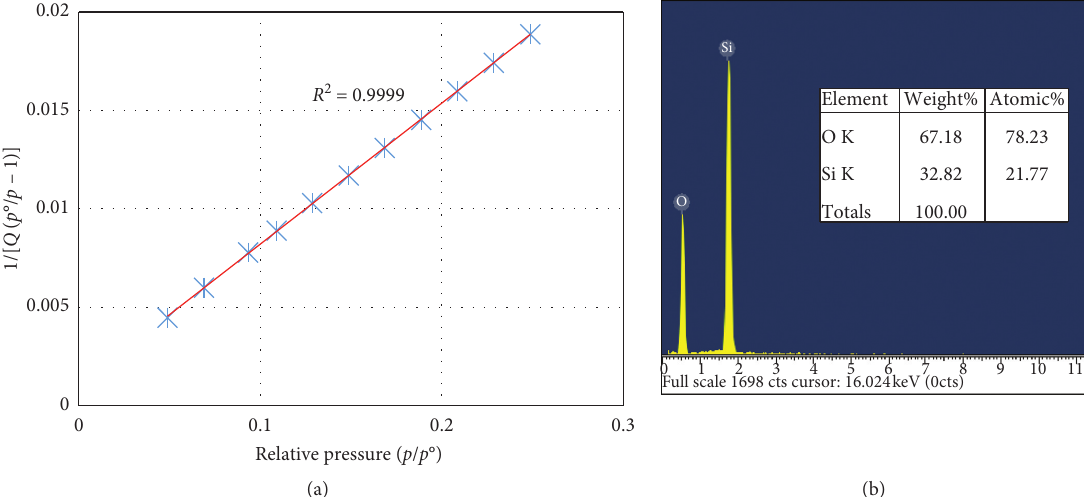
Figure 3: (a) BET isotherms for pore diameter and surface area calculations and (b) EDX spectra showing the presence of Si and O.